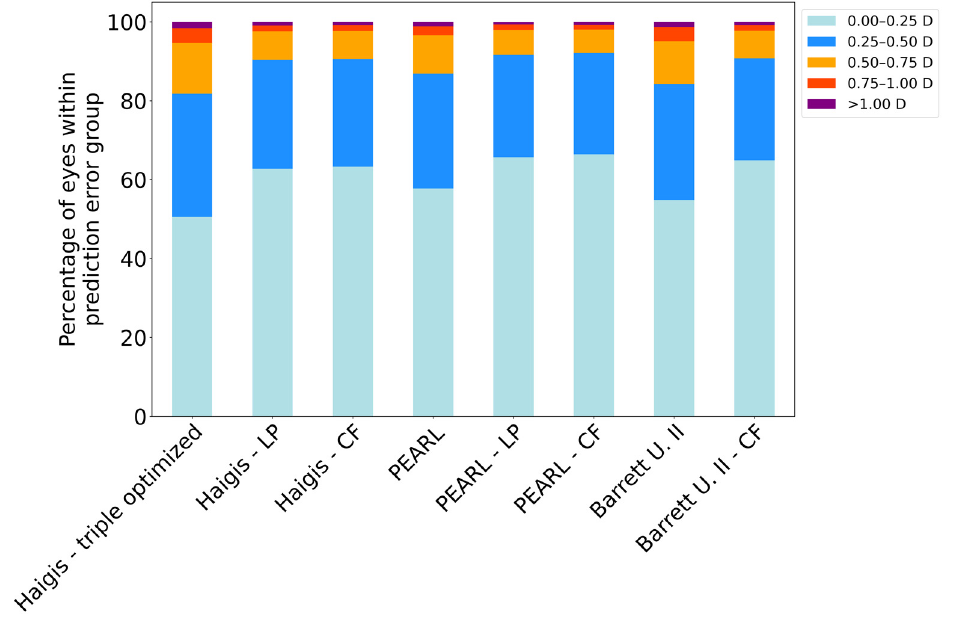
Figure 2. Percentage of eyes exhibiting prediction error of ± 0.25D, ± 0.50D, ± 0.75D, ± 1.0D, and >1.0D. Table 2. Comparison of second-eye formula and base formula precision.